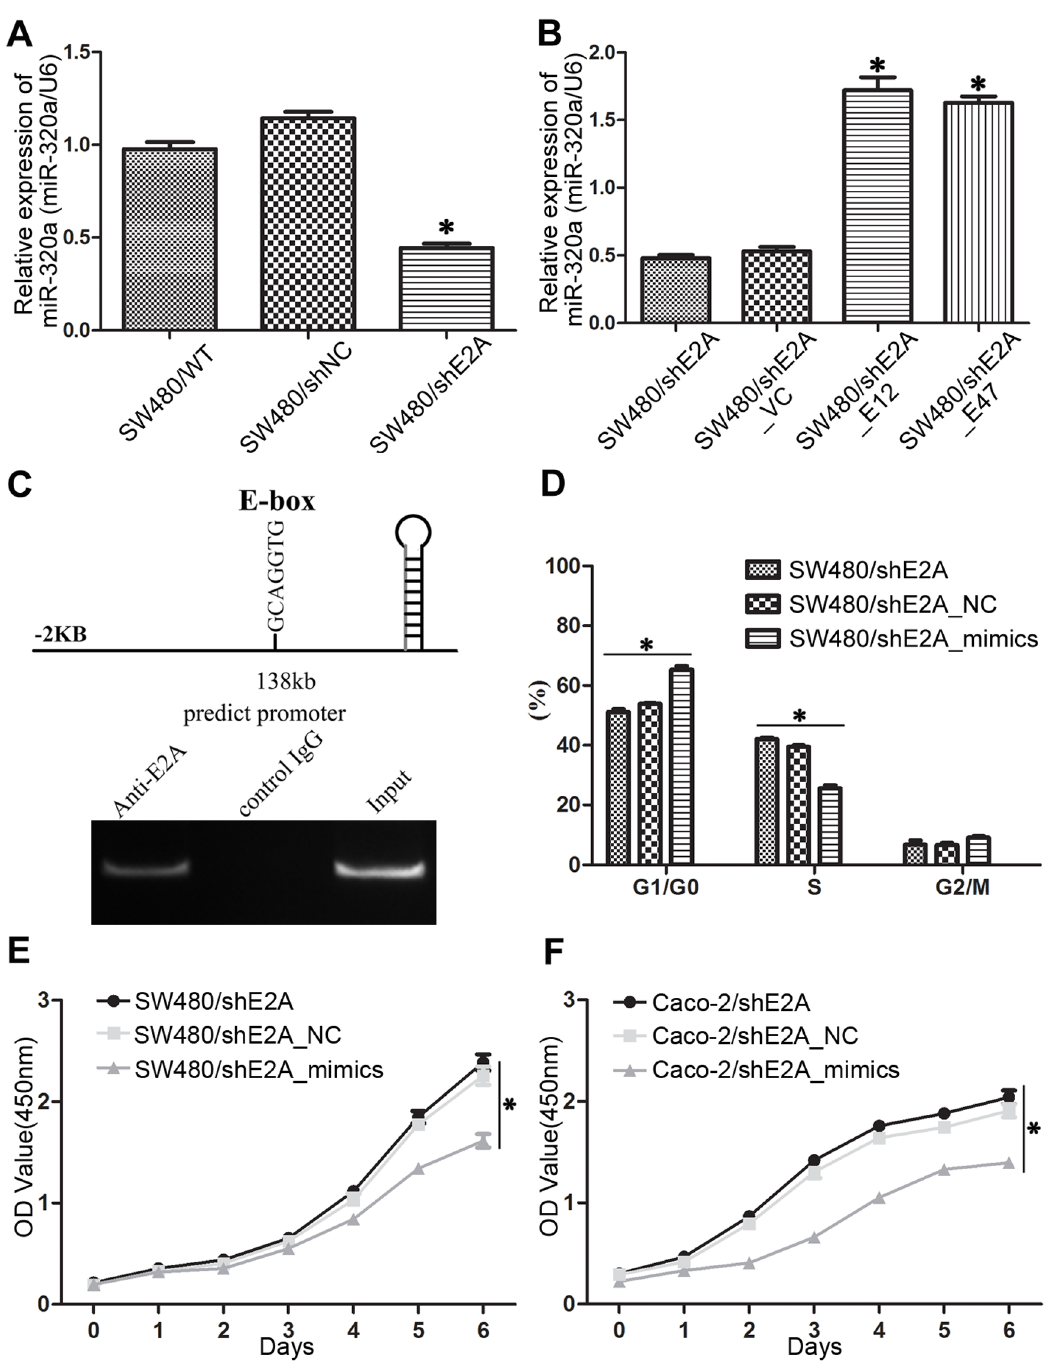
Figure 5. miR-320a is a direct target of E2A to regulate cell cycle and proliferation. (A) miR-320a expression was decreased in SW480/ shE2A cells as shown by qRT-PCR; (B) Co-transfection of E12 or E47 into SW480/shE2A cells could normalize the expression of miR-320a; (C) Upper panel: sequence of the miR-320a gene showing the E-box, the predicted binding site of E2A; lower panel: ChIP assay showed E2A bound to miR-320a at its E-box, GCAGGTG; Co-transfection of miR-320a mimics reversed the cell cycle changes (D) and cell growth (E) of SW480/shE2A cells; (F) Co- transfection of miR-320a mimics decreased cell proliferation rate of Caco-2/shE2A cells. Data is expressed with the means 6 SD from 3 independent experiments. (*, P , 0.05).